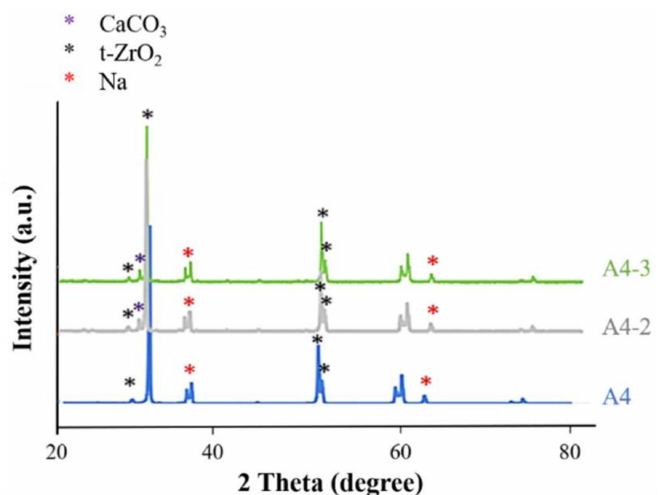
Figure 9. Alkali-treated zirconia (A4) was compared to A4-2 and A4-3 soaked with different concen- trations of calcium hydroxide, using XRD